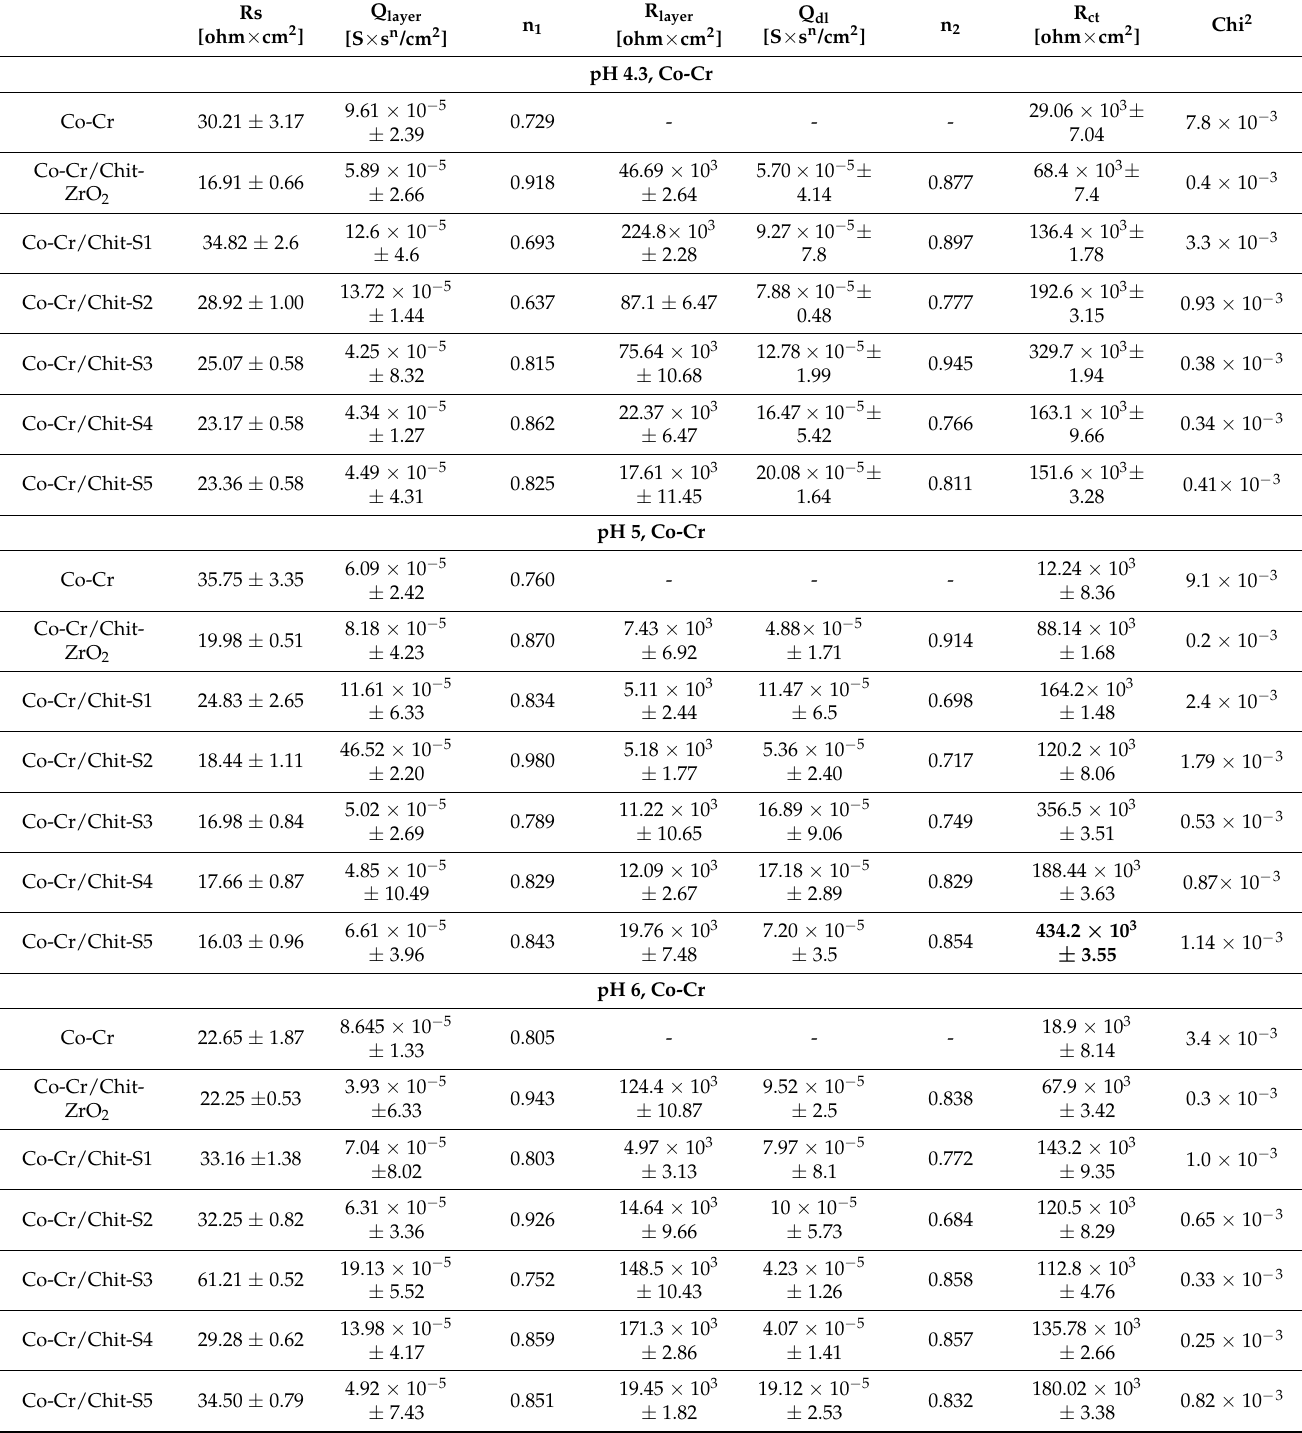
Table 3. Electrochemical impedance spectroscopy data of Co-Cr,Co-Cr/Chit-ZrO 2 and Co-Cr/Chit-Sx (where x = 1-5) after immersion in artificial saliva of different pH values, using R s (Q dl R c t) or R s (Q layer R layer )(Q dl R ct ) equivalent electric